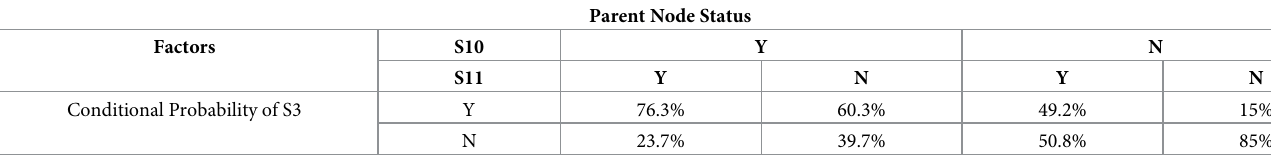
Table 9. CPT of sub node S3.